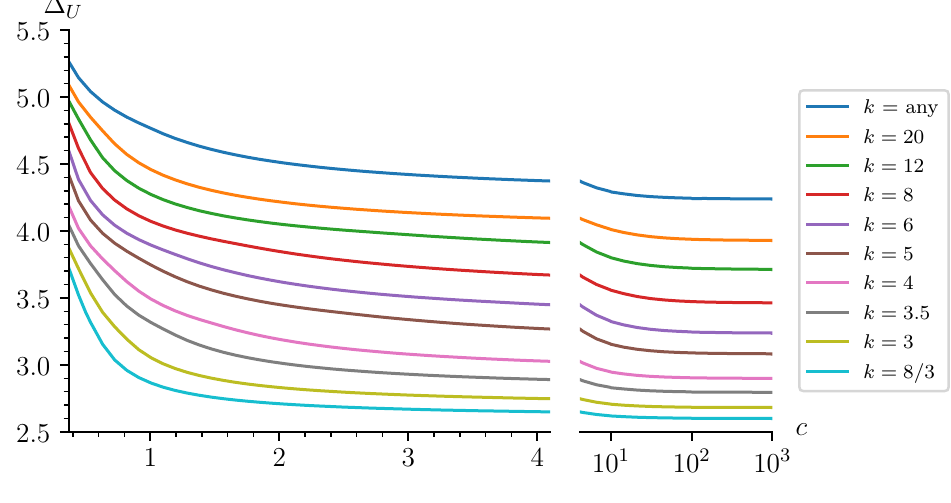
Figure 4 . Upper bound on the dimension ∆ U of the first singlet operator in the OPE M × M of two moment map operators. The values of the flavor central charge from bottom to top are k = 8 / 3 , 3 , 7 / 2 , 4 , 5 , 6 , 8 , 12 , 20 , any . The bounds for c = 10 3 and c = ∞ are identical with the resolution of the plot. All results are obtained at Λ = 32